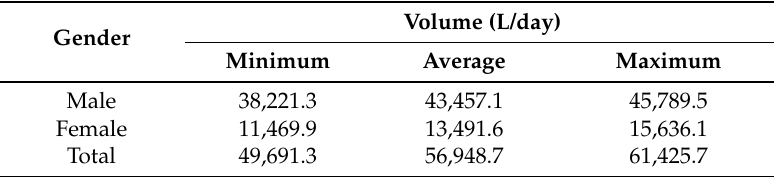
Table 2. Greywater generation of Monterrey Campus.